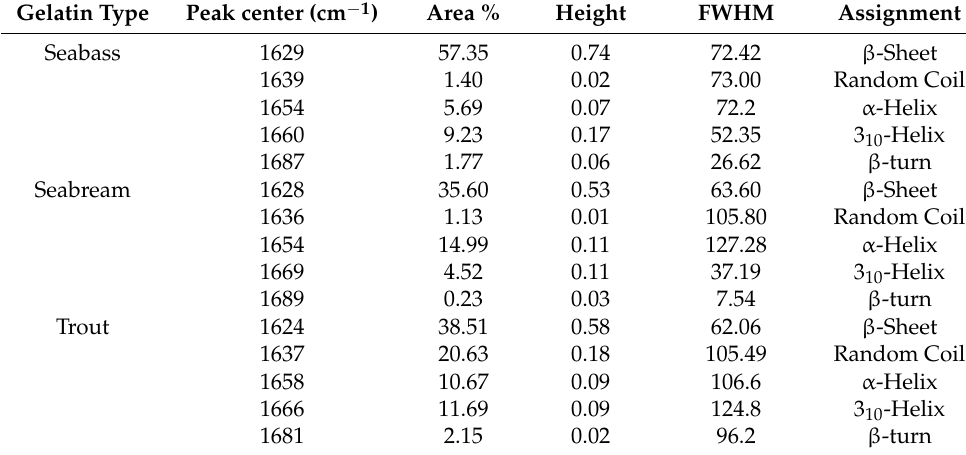
Table 6. Location and percent area contribution of the main secondary structures in the amide I region of seabass, seabream and trout gelatin. FWHM: Full width at half its maximum value, corresponding to the widths of the central peaks of the autocorrelation